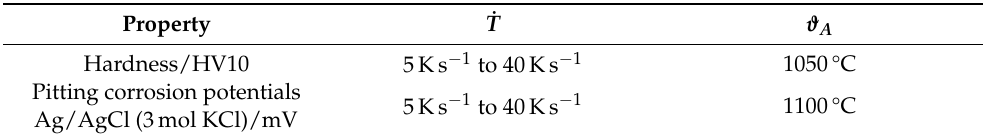
Table 10. Recommended cooling rates ˙ T and austenitizing temperatures ϑ A to obtain high hardness and corrosion